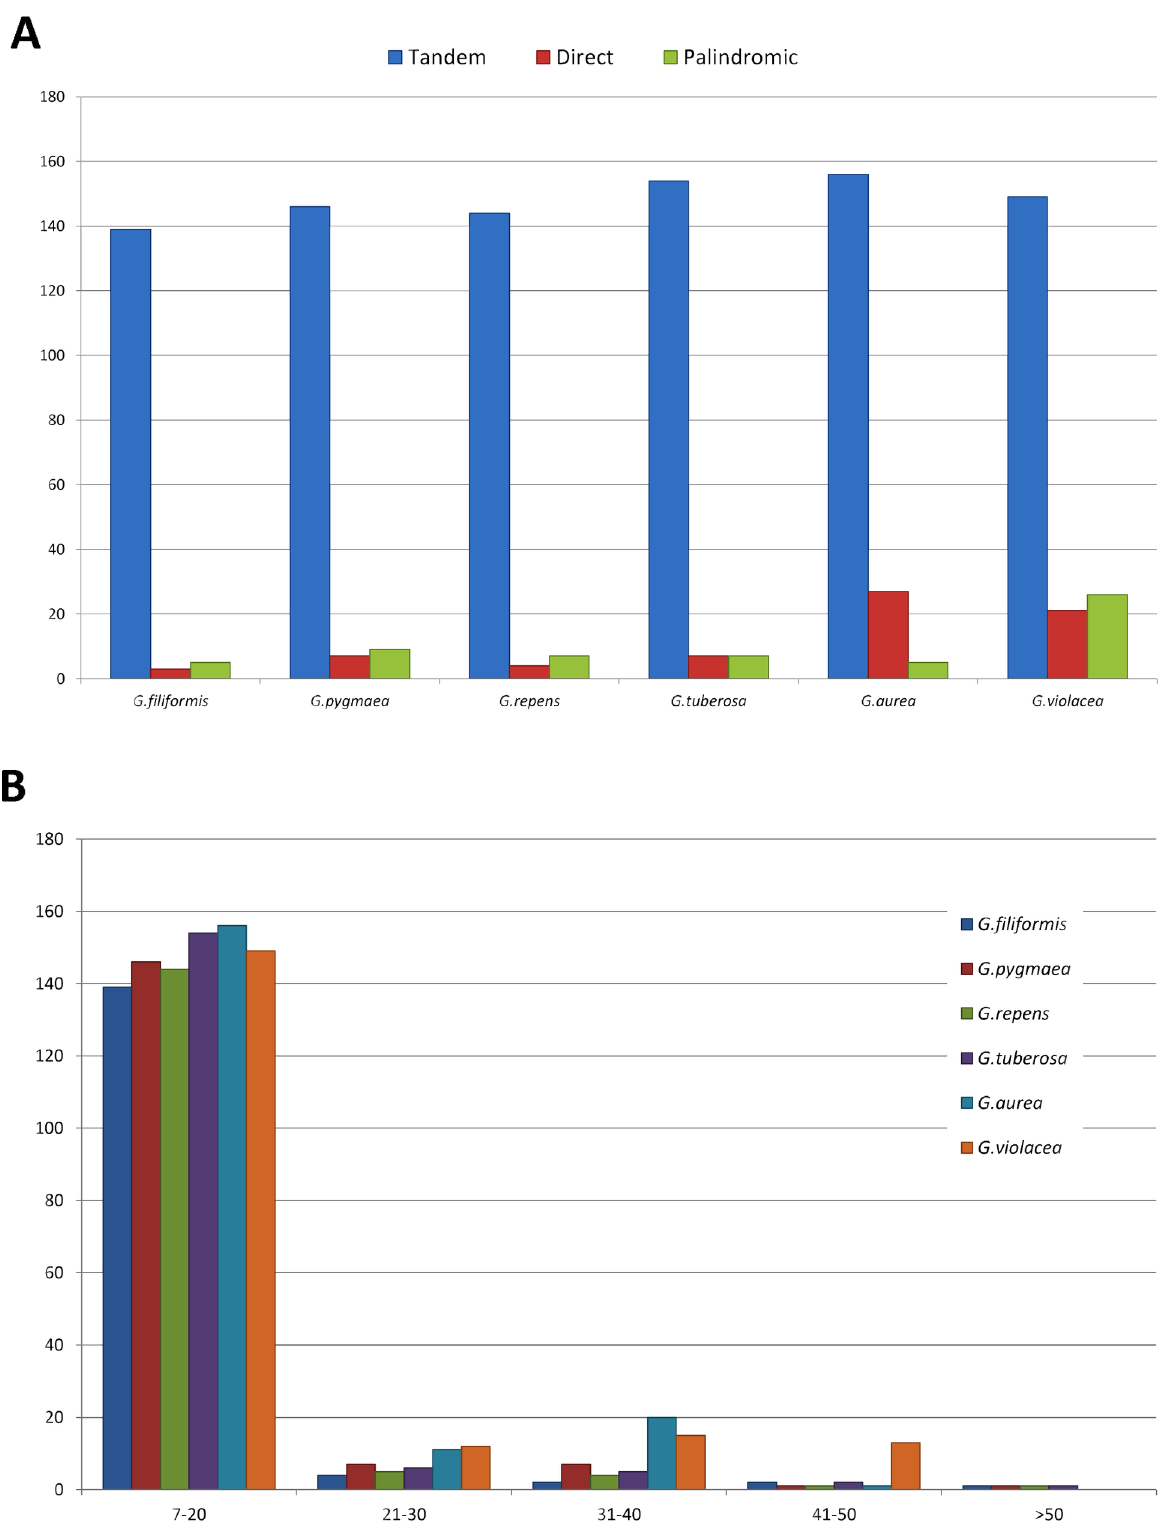
Fig 2. Analysis of repeatsin Genlisea chloroplast genomes. (A) Quantity of tandem, direct and palindromic repeats of each species. (B) Quantity of repeats by length.